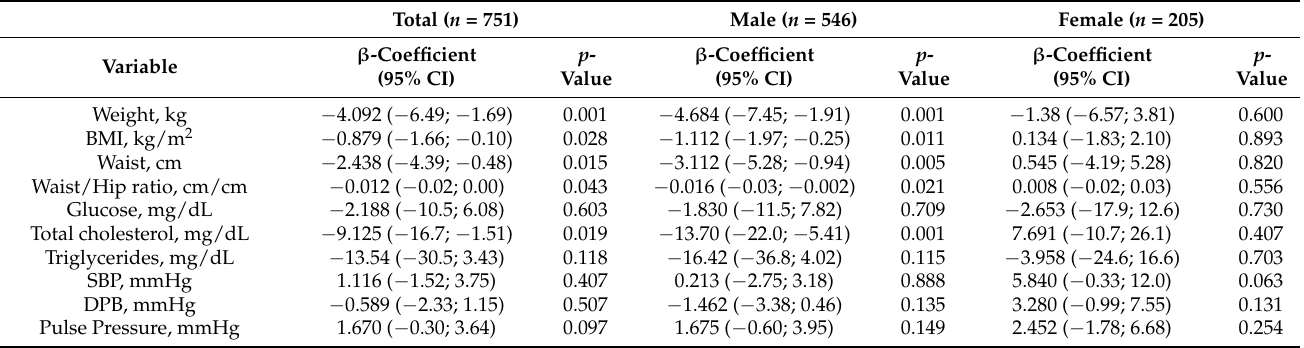
Table 3. Association between occupational physical activity (OPA) and cardiometabolic risk factors. Total ( n = 751) Male ( n = 546) Female ( n =